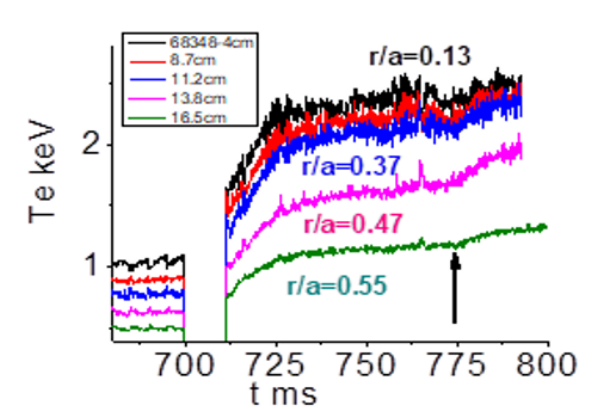
Fig. 4. Timetraces of Te in shot 68348, the start of Te rise is shown by arrow.